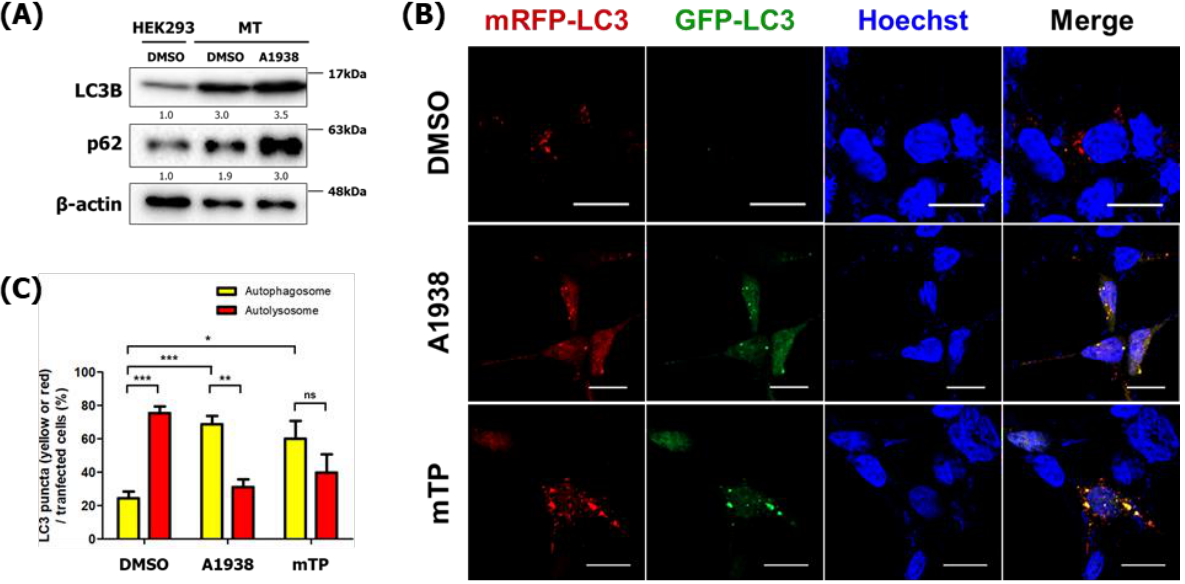
Figure 5. A1938 regulates autophagy flux by suppression of mROS generation in MT cells. ( A ) Cells treated with A1938 for 24 h in a serum-free medium. The relative band intensities value was nor- malized to β -actin (loading control). The normalized protein levels are shown under each band. ( B ) Confocal microscopy images of HEK293 and MT cells transfected with mRFP-GFP-LC3 and treated with DMSO, A1938, or Mito-Tempo (mTP) for 24 h. Scale bar, 20 µm. Quantification of data indicat- ing red puncta (autolysosome) versus yellow puncta (autophagosome) is shown in ( C ). Values are the means ± SEM; statistical significance was assessed using a paired t -test. n = 10 cells, ns, p > 0.05, * p < 0.05, ** p < 0.01, *** p < 0.001.